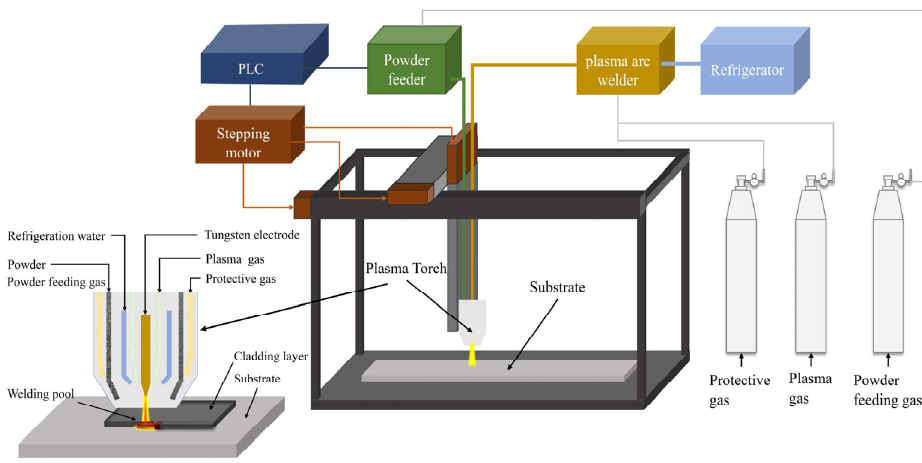
Figure 4. Schematic diagram of ultrasonic plasma cladding equipment. Table 2. Processing parameters in plasma cladding.